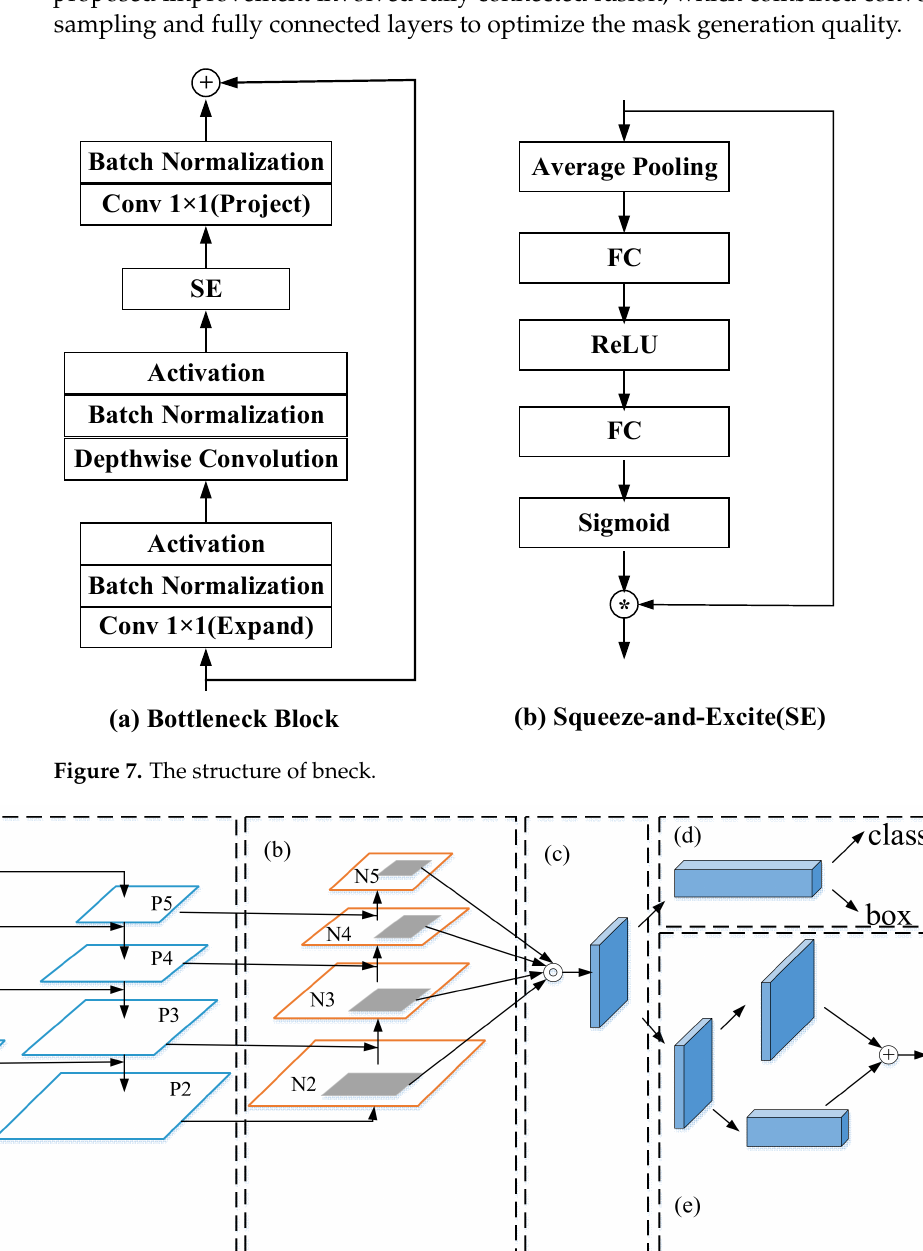
Figure 8. The structure of PANet. ( a ) FPN backbone, ( b ) Bottom-up path augmentation, ( c ) Adaptive feature pooling, ( d ) Box branch, and ( e ) Fully-connected fusion.